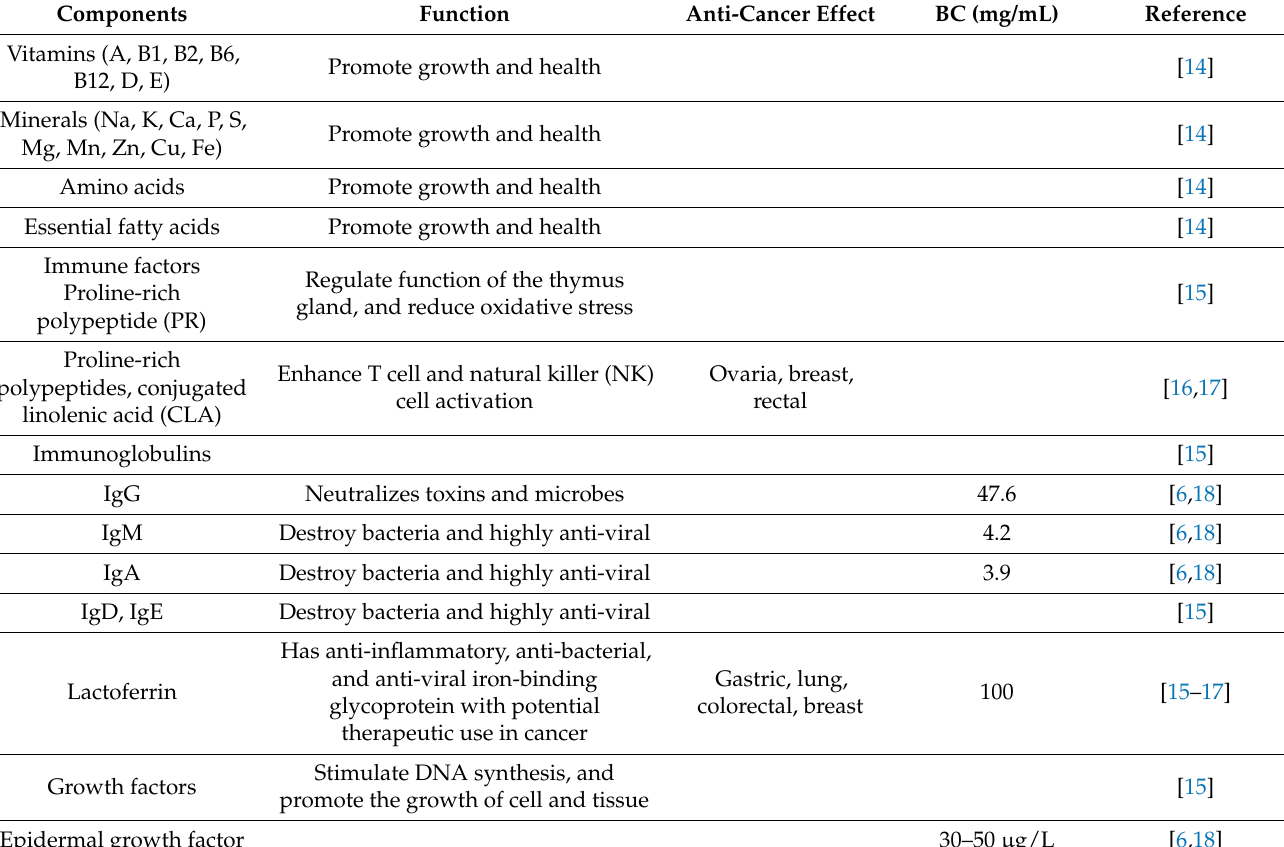
Table 1. Bovine colostrum (BC) components: functions and anti-cancer effects in children and adults. Components